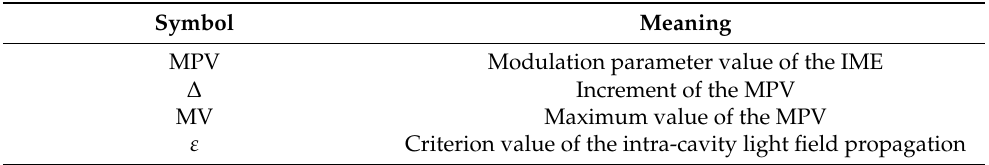
Table 2. The symbols and the corresponding